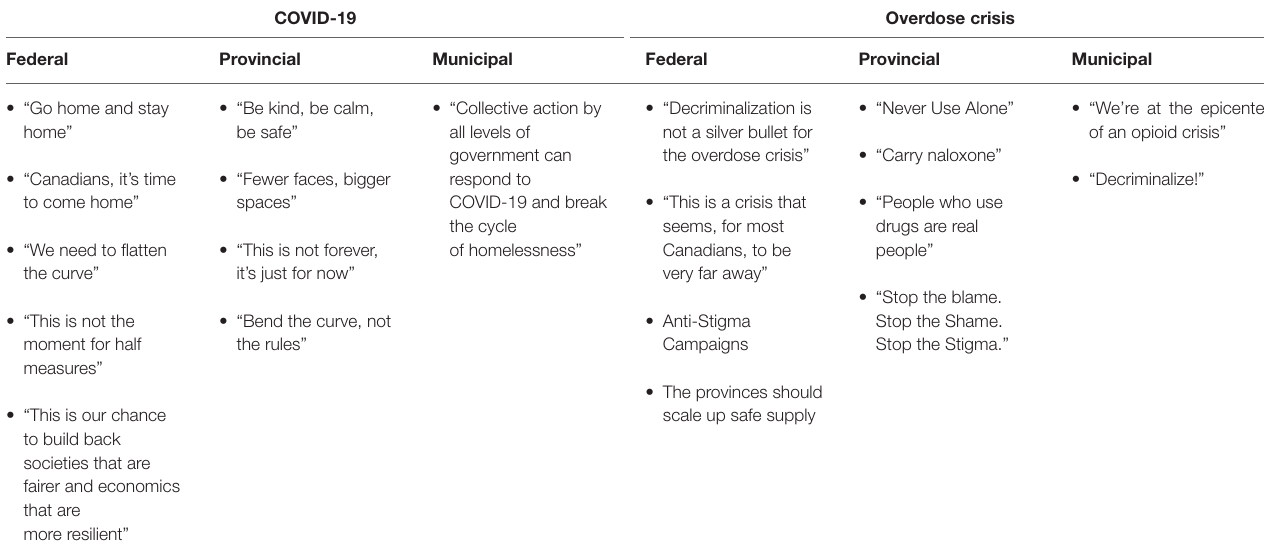
TABLE 4 | What messaging has helped/hindered the information loop result in desired behavioral